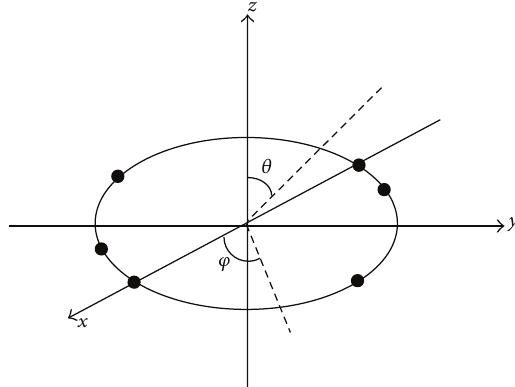
Figure 9: Structure of the UCA and the coordinate system.